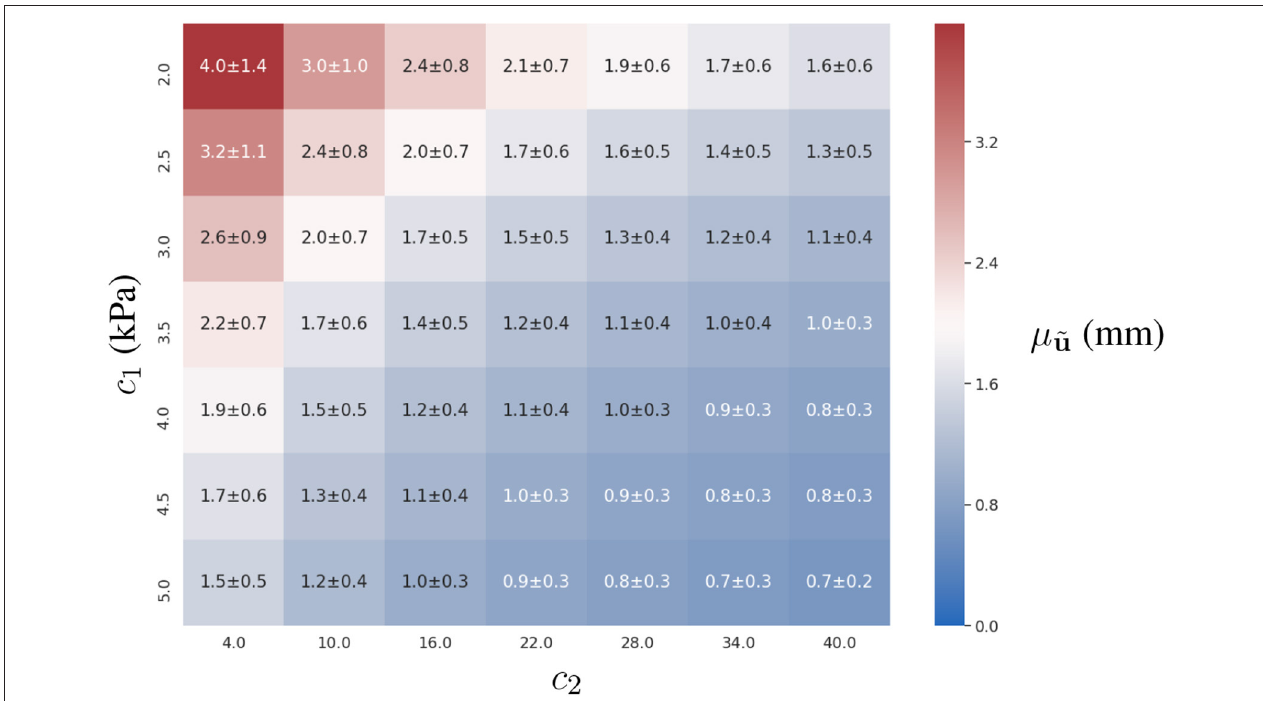
FIGURE 2 | Mean displacement of the ventricular wall (denoted µ ˆ u ) for different combinations of the constitutive parameters c 1 and c 2 , and an intra-ventricular pressure load of p = 0.9 kPa. For details of mean displacements for other loads, refer to the Supplementary Material